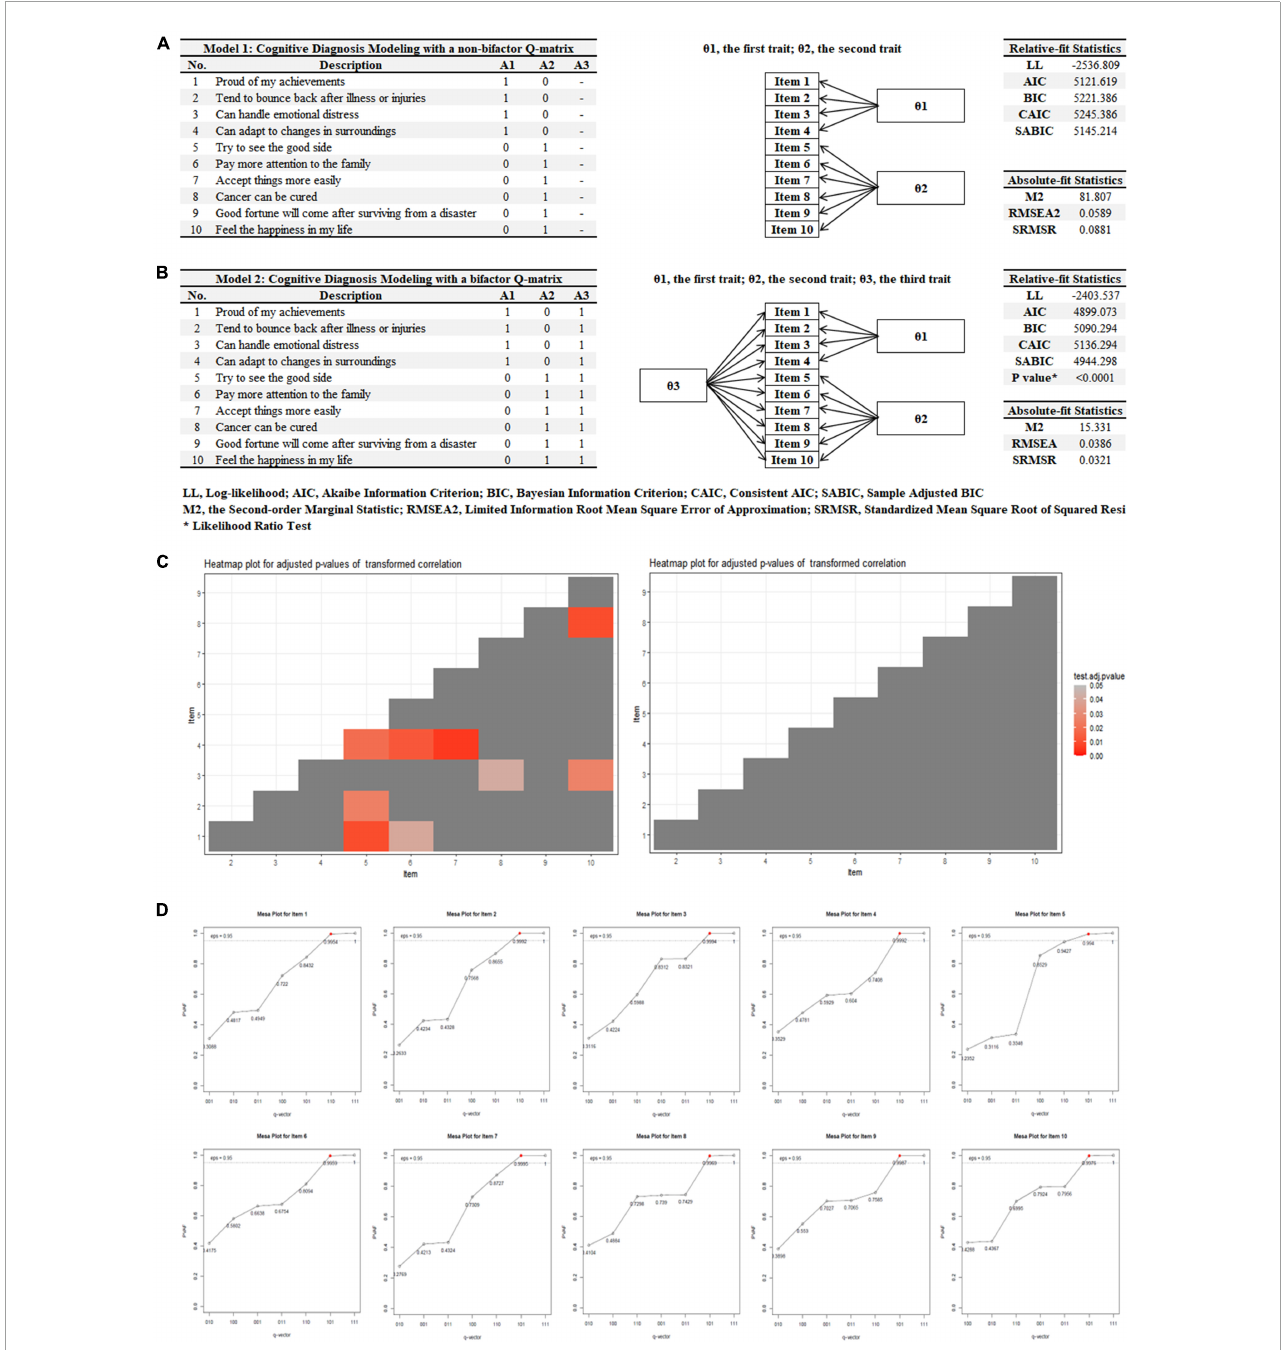
FIGURE2 Q-matrix comparison and validation. (A) A non-bifactor Q-matrix, (B) a bifactor Q-matrix, (C) heatmaps for adjusted p -values of transformed correlation, and (D) mesa plots mapping attributes to items.